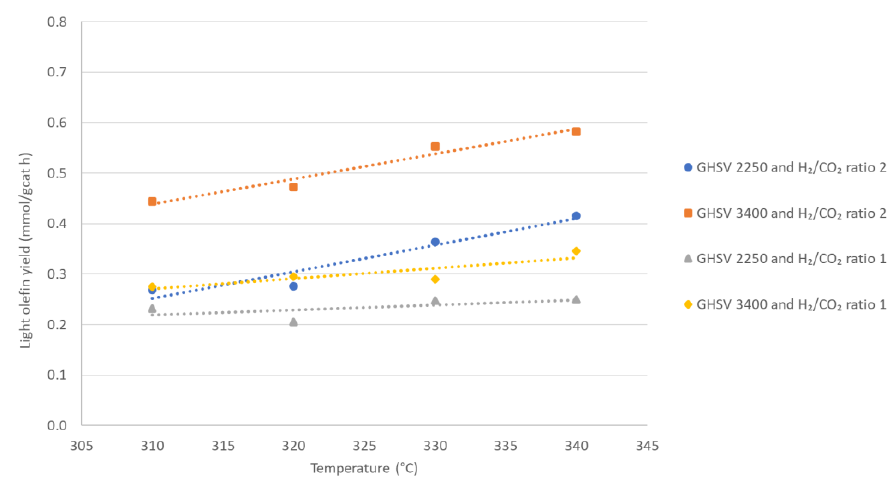
Figure 8. Light olefin yield at different process conditions.